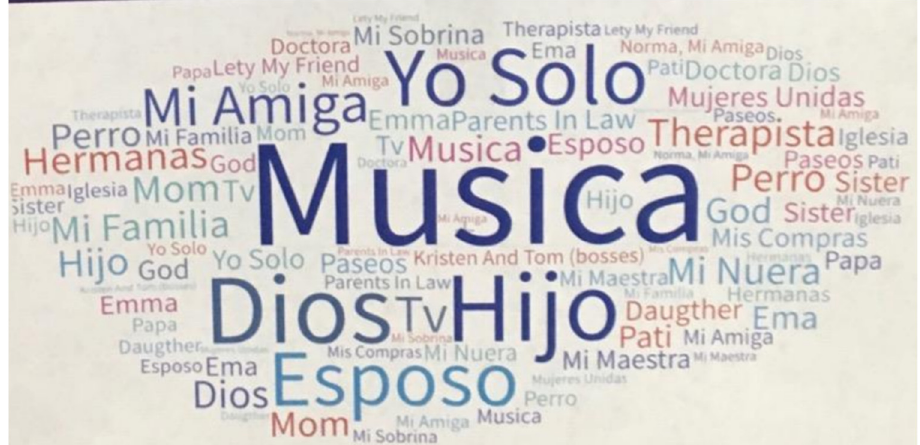
Figure 1. Word cloud of responses to how women found stress relief and social support. Women generated individual responses, and the teachers then converted them into a word cloud. Word clouds, a useful tool for representing data distributions and relative proportions, were a popular form of visualization for this beginner-level English classroom.